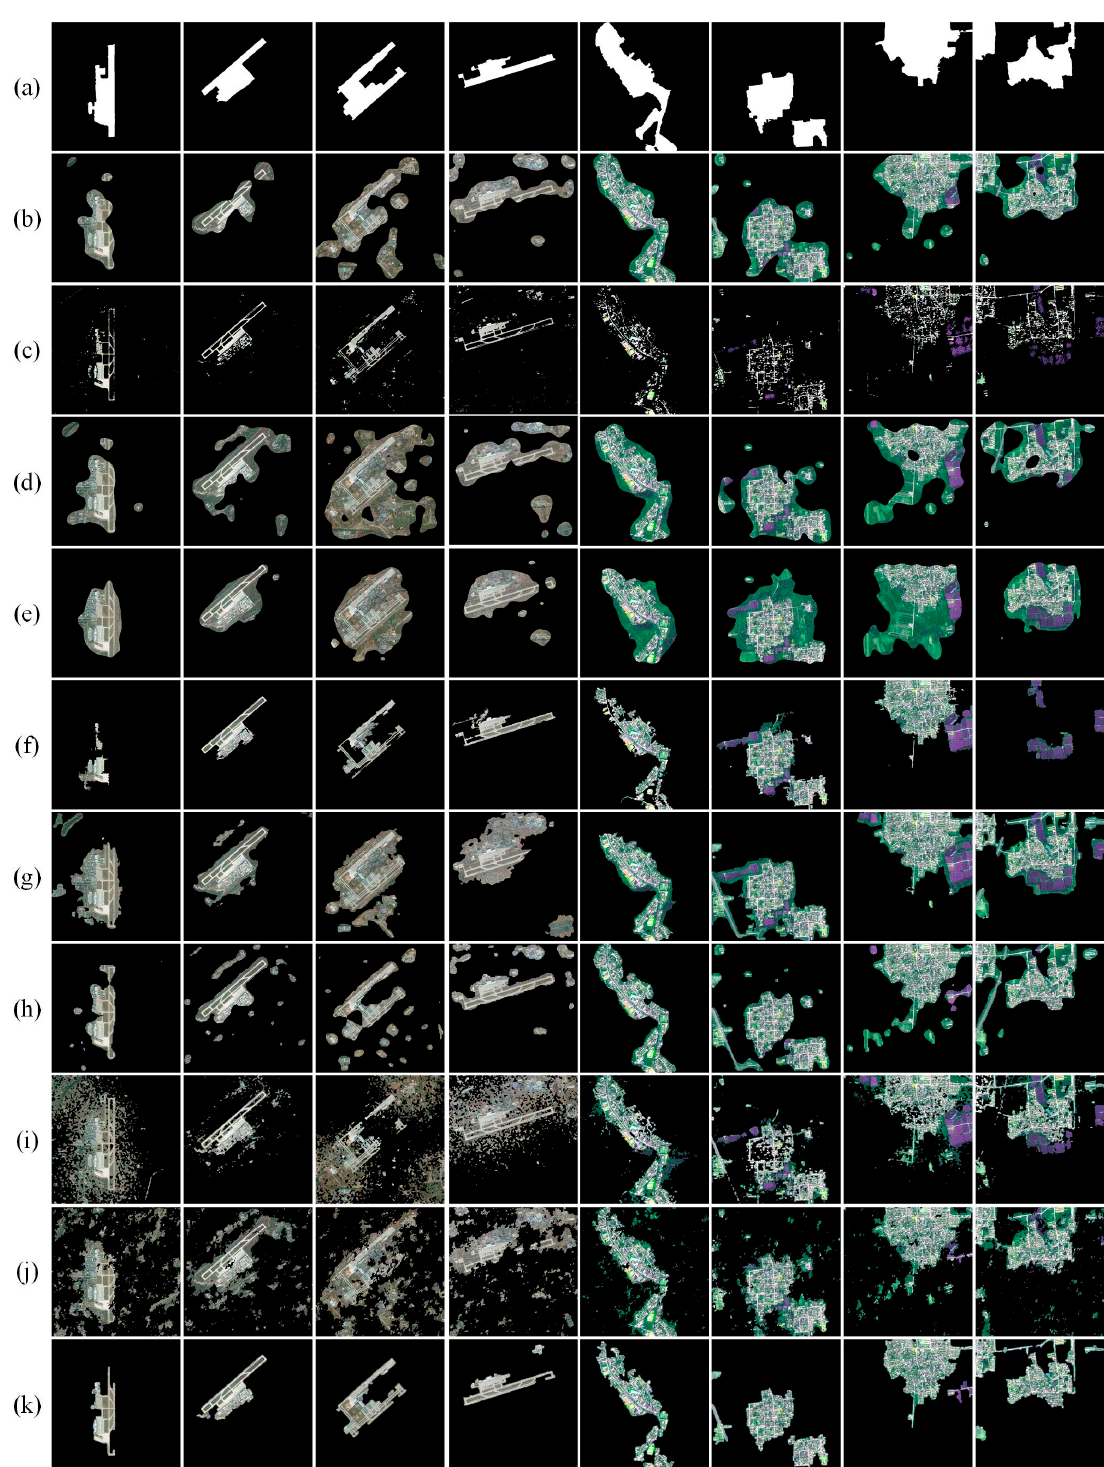
Figure 11. Comparison of ROIs for images polluted by Gaussian noise (Standard Variance = 0.01) (first four images are from the SPOT5 satellite and last four are from Google Earth): ( a ) ground truth; ( b ) SR; ( c ) FT; ( d ) ITTI; ( e ) GBVS; ( f ) H; ( g ) CA; ( h ) FDA; ( i ) WT; ( j ) MFF; and ( k ) LI.